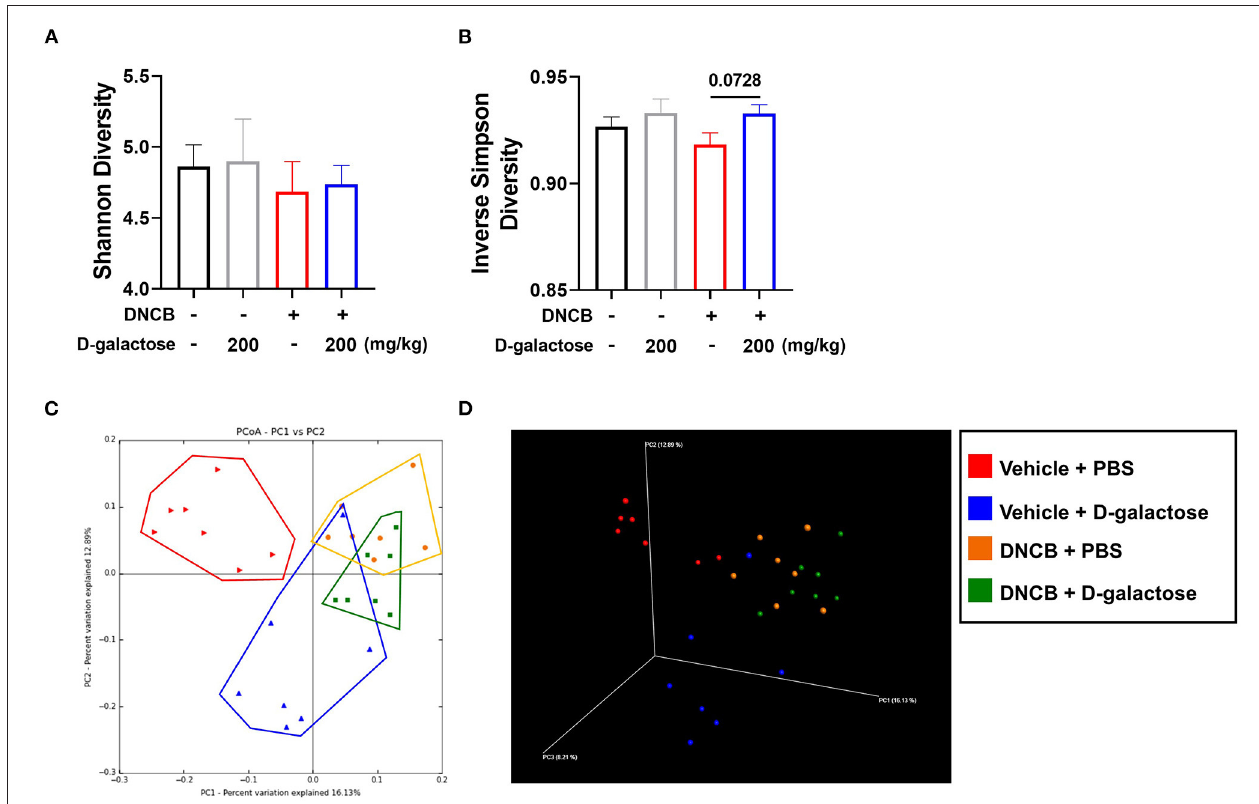
FIGURE 5 | Effects of D-galactose on alpha and beta diversity. Alpha and beta diversity of intestinal microbiota in vehicle-treated and DNCB-treated mice with or without D-galactose treatment was evaluated. (A,B) Richness of intestinal microbiota in indicated by Shannon diversity and Inverse Simpson Diversity (C,D) Beta diversity 2D and 3D patterns were determined by principal coordinate analysis. PBS + Vehicle (Red), D-galactose + Vehicle (Blue), PBS + DNCB (Yellow), D-galactose + DNCB (Green). The significance of differences between the groups was assessed using Mann-Whitney U -test, with the level of significance set at * P < 0.05, ** P < 0.01, *** P <